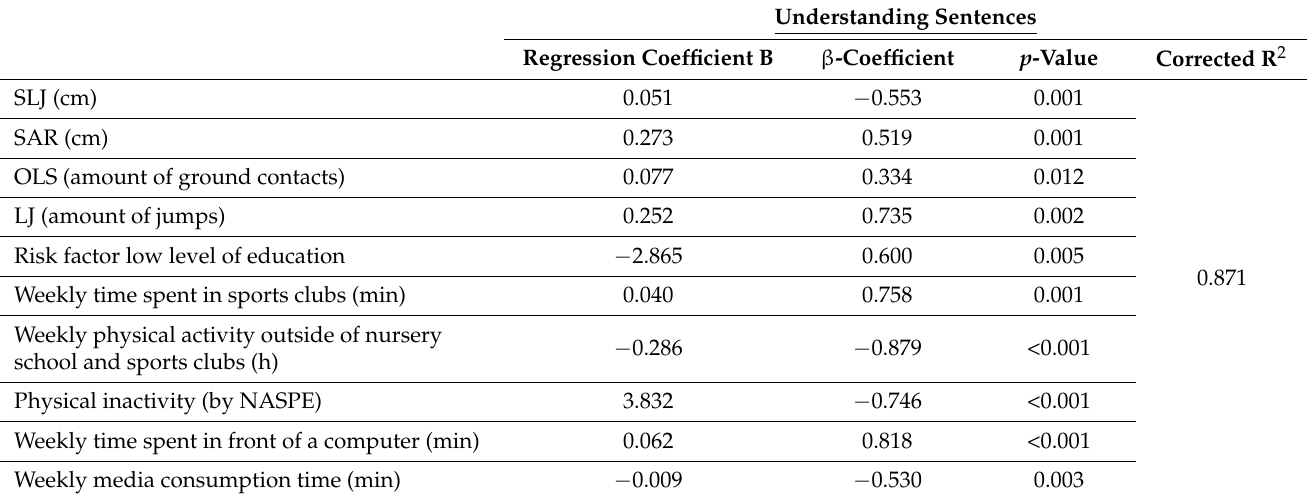
Table 5. Multiple linear regression analysis—End model of the subcategory ‘Understanding sentences’.